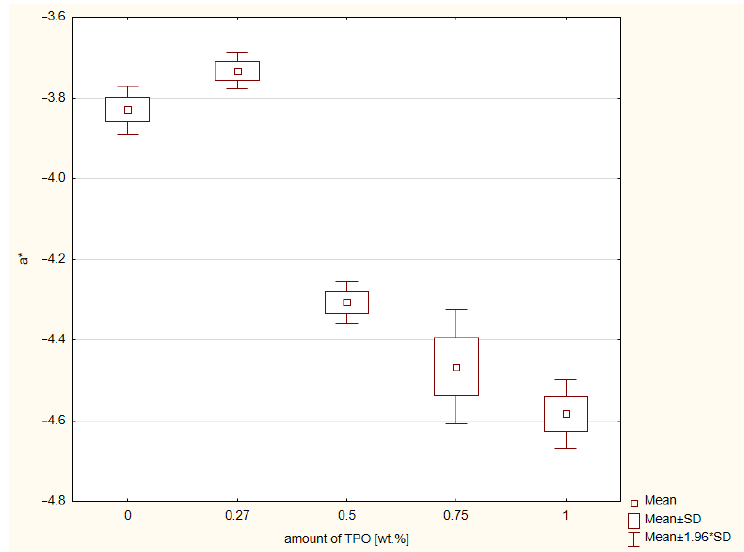
Figure 5. Box-and-whisker plot of results of color measurement CIE L* a* b* according to the axis a* of experimental composites containing different concentration of TPO and the control group CQ and DMAEMA; photopolymerization both side of samples 20 s. per 2 mm thickness of composites with Valo lamp light intensity 1450 mW/cm 2 .